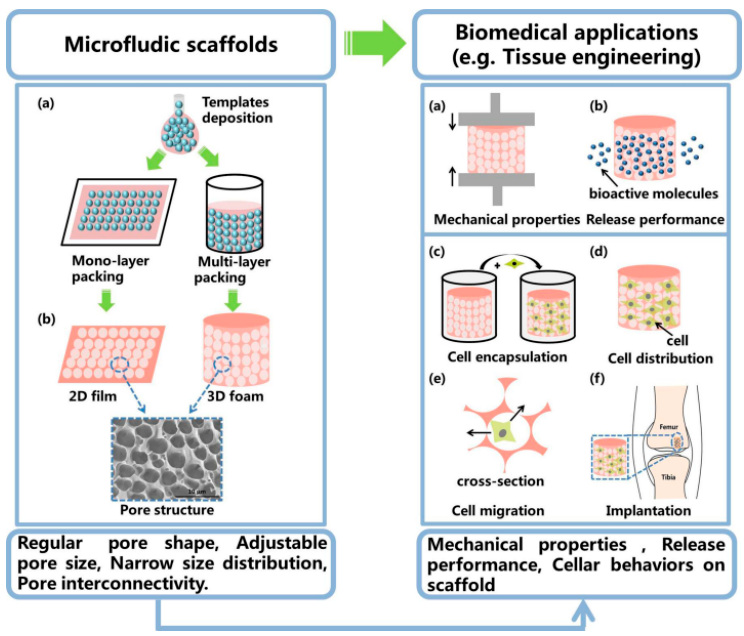
Figure 6. Schematic diagram: microfluidic scaffolds and their biomedical applications, especially in TE.